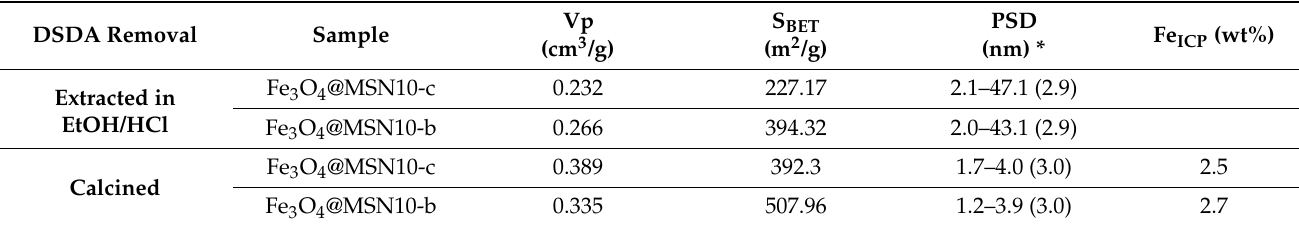
Table 1. Textural properties of the extracted and calcined Fe 3 O 4 @MSNs.